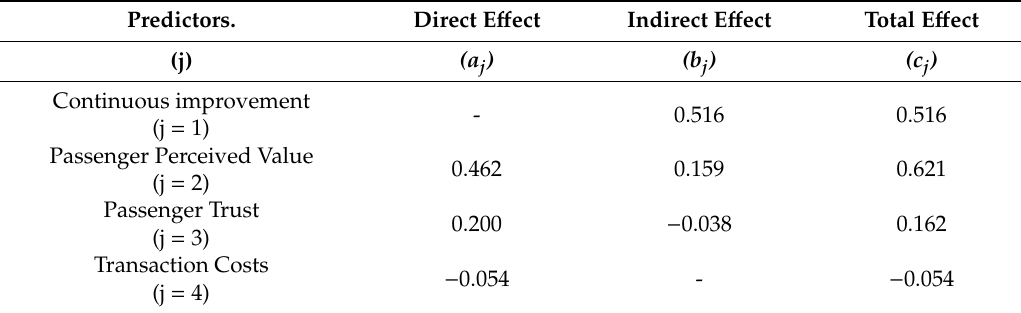
Table 7. Direct, indirect and total e ff ects of antecedent variables on passengers’ loyalty.